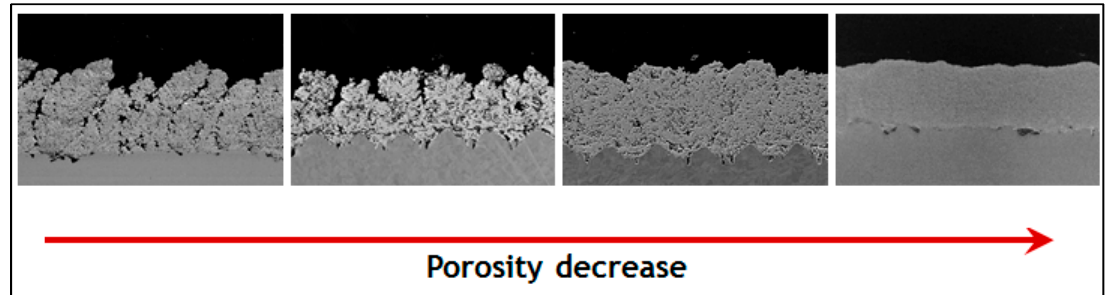
Figure 5. Various microstructures of YSZ coatings produced by SPS, after [27]. Reproduced with permission from [Advances in Materials Science Research], Nova, 2016.